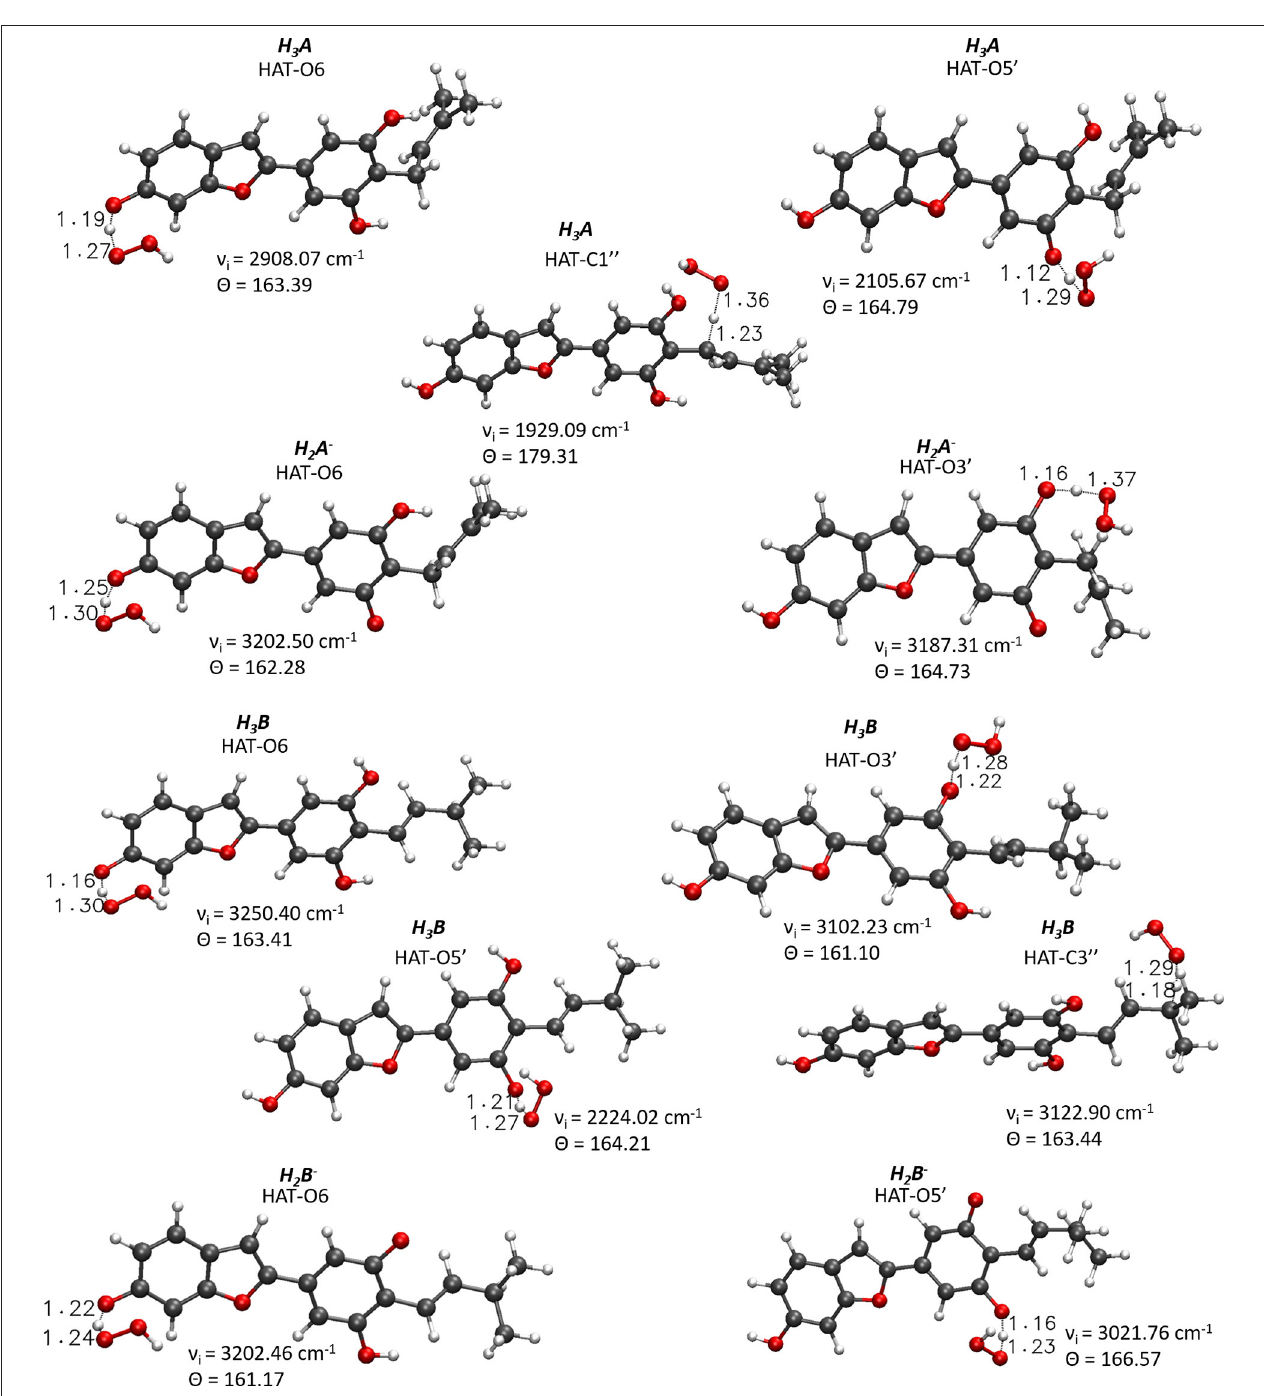
FIGURE 5 | Main geometrical parameters for the optimized TSs structures for the neutral and monoanionic species of moracin C and iso -moracin C involved in the HAT mechanism. Bond lengths are in Å, angles in degrees, and imaginary frequencies in cm − 1 .